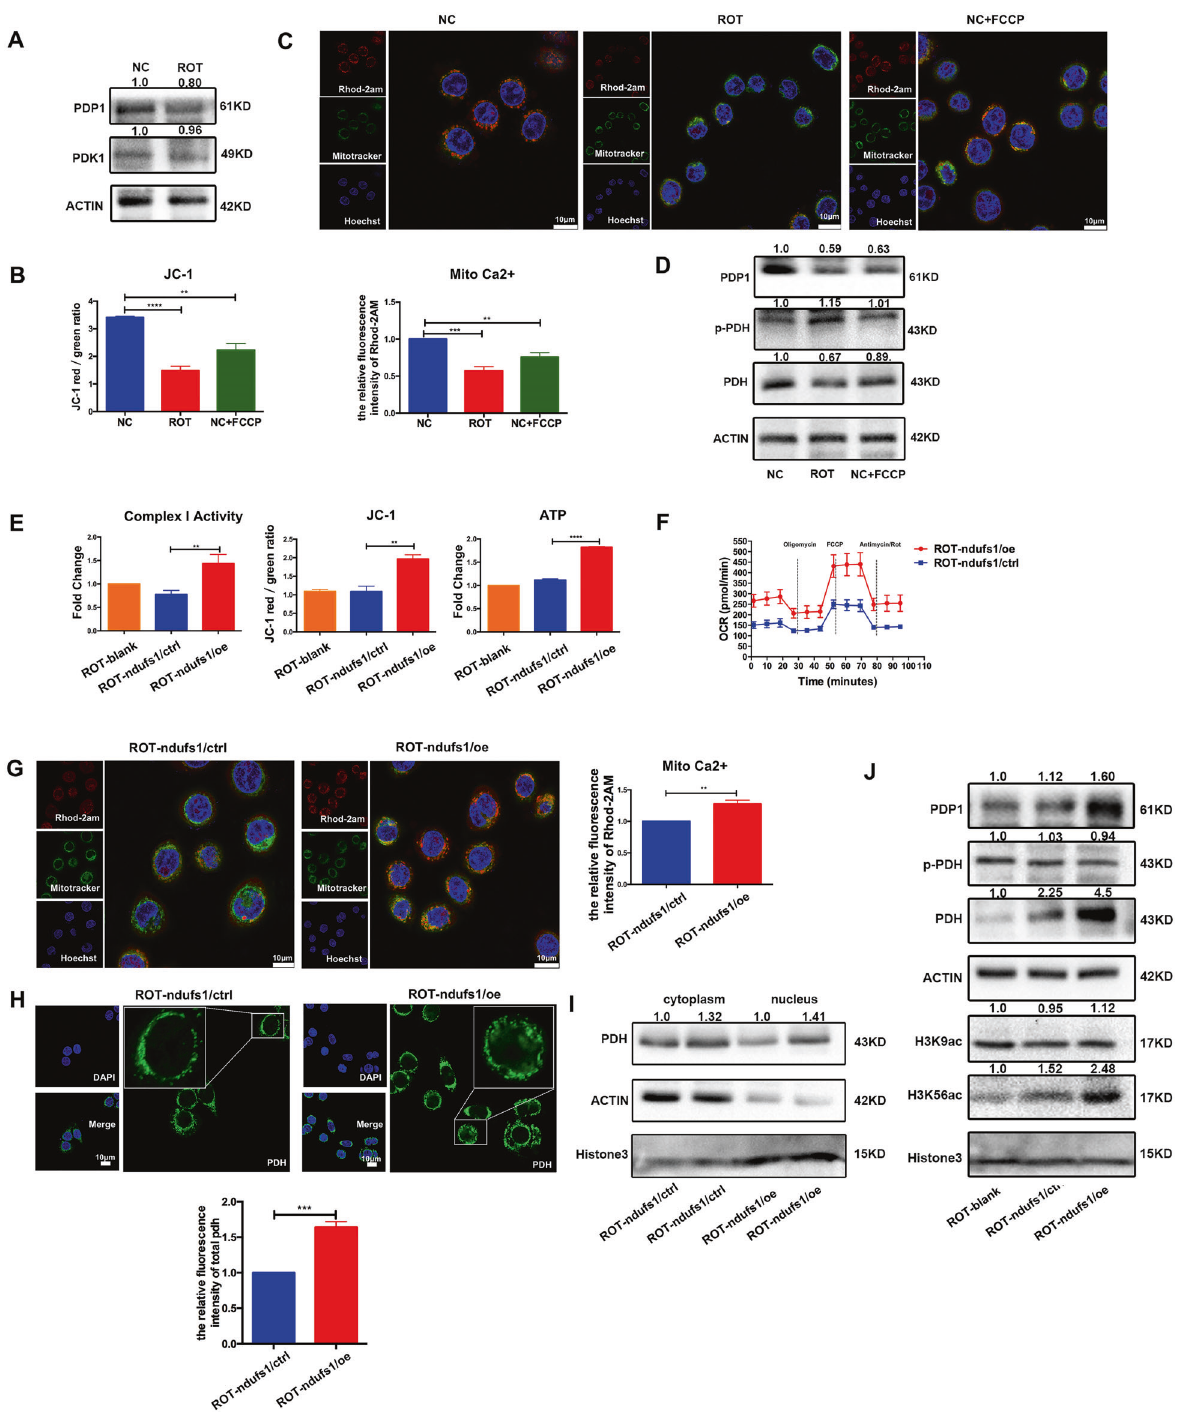
Fig. 4 Complex I de fi ciency activated the [Ca 2 + ]m – PDP1-PDH-histone acetylation retrograde signaling pathway. A Western blot analysis of PDK1 and PDP1 protein in NC and ROT cells. B Statistical analysis of ΔΨ m in NC, NC + FCCP (10 μ M), ROT cells. ( n = 3), ** P < 0.01, **** P < 0.0001. C The above cells were incubated with the fl uorescent dyes Rhod-2AM (5 μ M, red), Mitotracker (200 nM, green) and Hoechst (2 μ g/ml, blue), rotenone and FCCP caused a rapid decrease in [Ca 2 + ] m . Scale bar:10 μ m. Relative fl uorescence intensity was shown, ( n = 3), ** P < 0.01, * ** P < 0.001. D Levels of PDP1, p-PDH, and PDH protein in NC, NC + FCCP, and ROT cells. E – F Overexpression of NDUFS1 could increase complex I activity, oxygen consumption, ATP and the ΔΨ m. ( n = 3), ** P < 0.01, **** P < 0.0001. G [Ca 2 + ] m level in ROT-ndufs1/ctrl and ROT- ndufs1/oe cells. Scale bar:10 μ m. Relative fl uorescence intensity was shown, ( n = 3), ** P < 0.01. H IF staining of PDH in ROT-ndufs1/ctrl and ROT-ndufs1/oe cells, scale bar:10 μ m. Relative fl uorescence intensity was shown, ( n = 5), *** P < 0.001. I Levels of PDH expression in extracted nucleus and cytoplasm in ROT-ndufs1/ctrl and ROT-ndufs1/oe cells. J Western blot analysis of PDP1, p-PDH, PDH and histone acetylation protein in ROT-balnk, ROT-ndufs1/ctrl and ROT-ndufs1/oe cells. Data are presented as the means ± s.e.m.